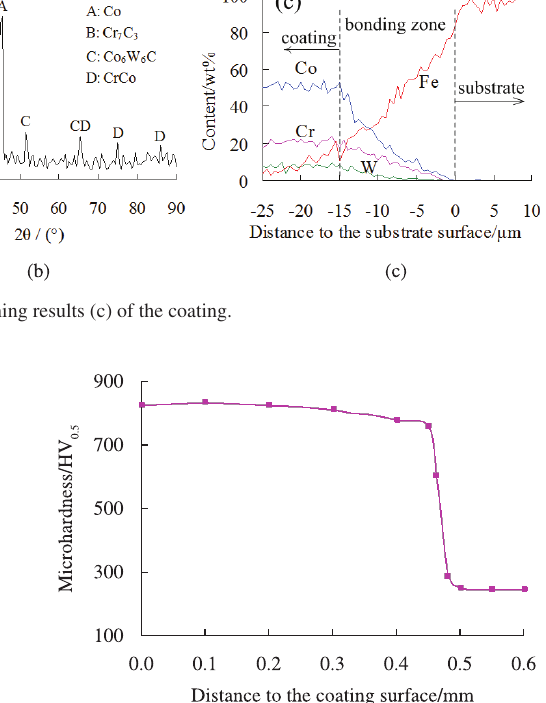
Figure 3. Microhardness along the coating depth